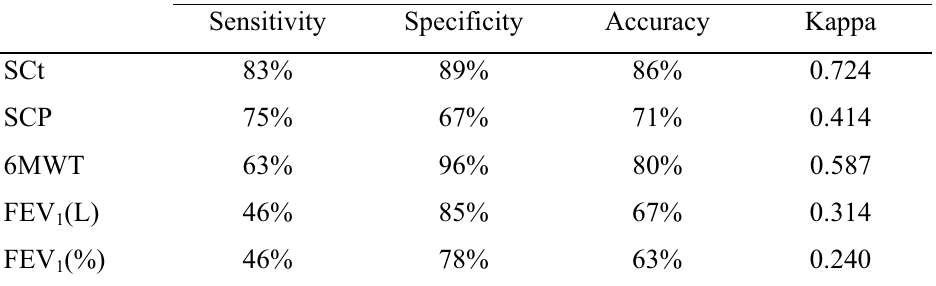
max as gold-standard 2